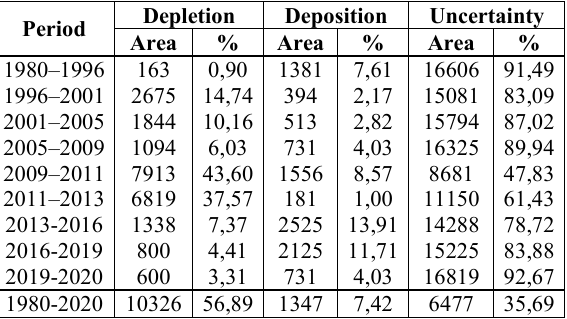
Table 3. Areas affected by erosion processes. Units are in m 2 .